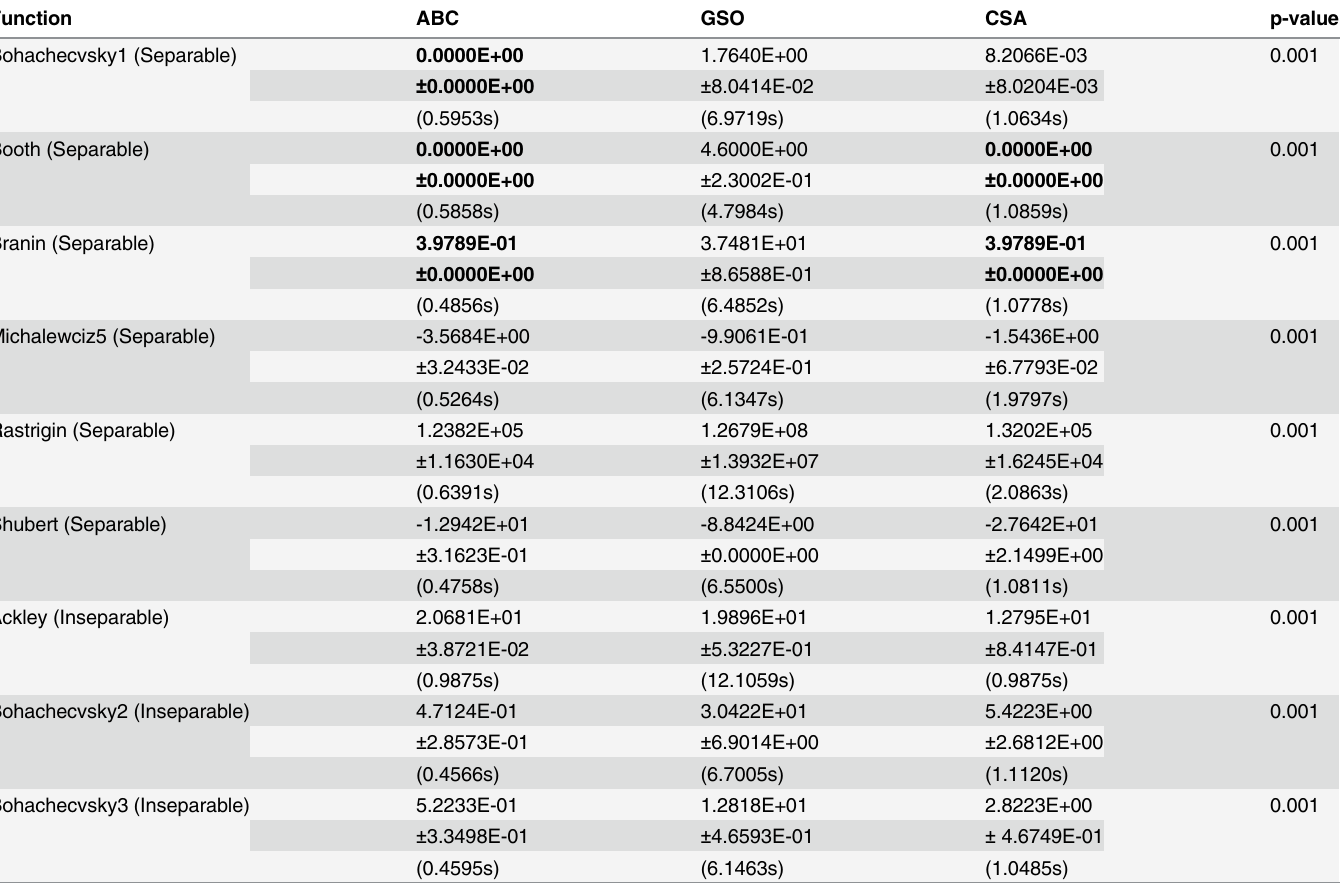
Table 6. Benchmark Functions Comparison of mean error (Mean ± SD) and time (Seconds) on Several Optimization Techniques. Function ABC GSO